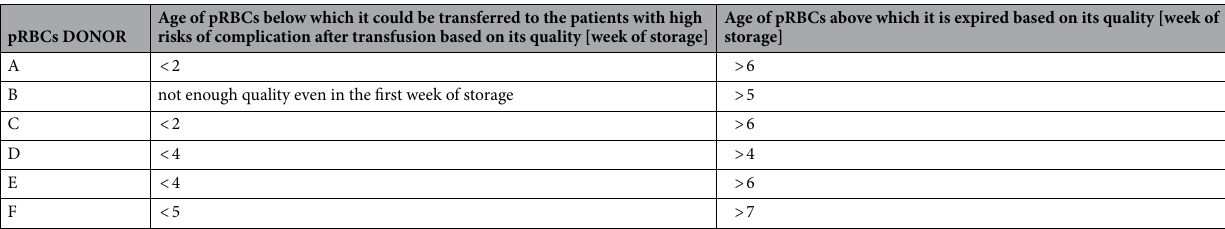
Table 1. Summary of the results of the pRBCs analysis indicating the time period for exclusion in transfusion for the pRBCs (donors A-F) based on not fulfilling the proper reference values based on the label-free RS methodology (analysis of the LAC, GLC, HGB and LPD values presented in Additional File 1: Figs. S9–S11).